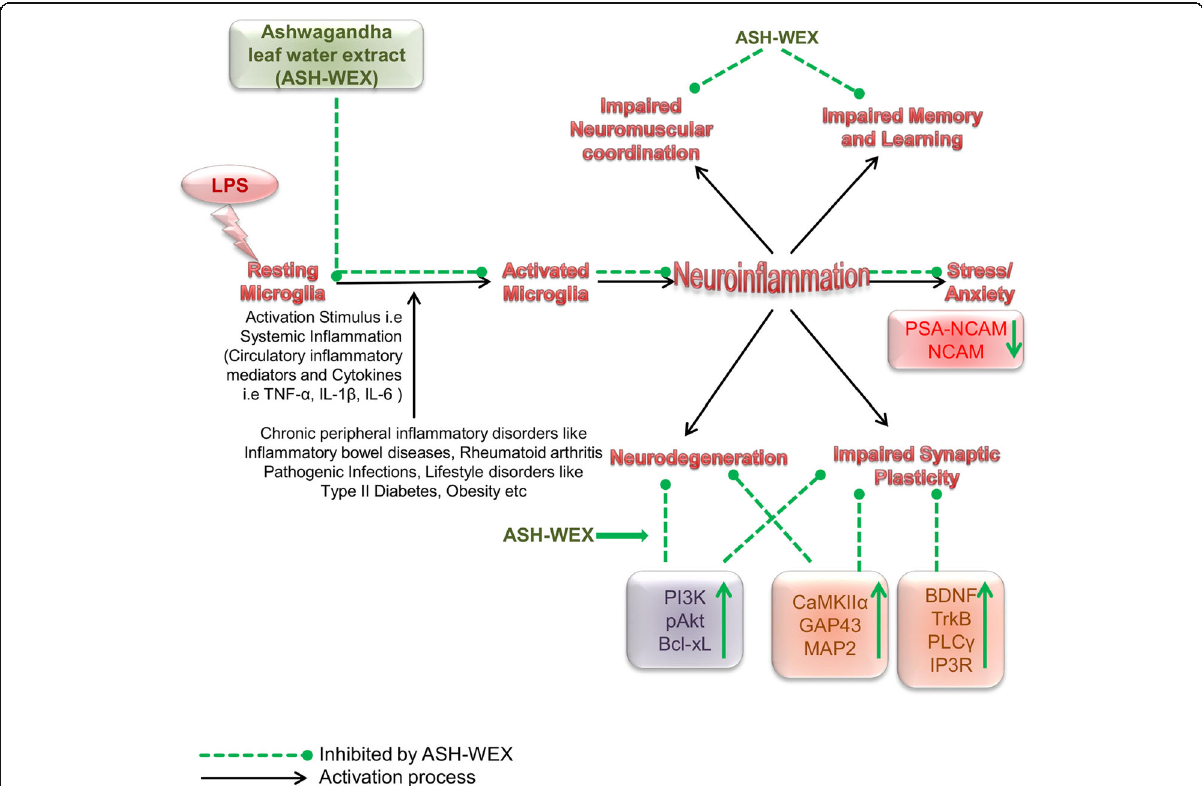
Fig. 8 Graphical representation of the study LPS (i.p.) induced sickness behavior, systemic inflammation driven neuroinflammation, and ultimately leads to neurodegeneration by adversely affecting key pathways involved in synaptic plasticity and cell survival. ASH-WEX supplementation reduced stress, sickness behavior and promoted the working memory and learning functions as well as neuro-muscular coordination impaired by LPS treatment. Ashwagandha exhibits its pleotropic neuroprotective activity by targeting various pathways and proteins involved in synaptic plasticity and cell survival such as BDNF-TrkB, PLC γ -IP3, PI3K-Akt pathways thereby promoting neuronal health and vitality. ( ↑ indicates “ upregulation ” , ↓ indicates “ downregulation ” , dotted arrows in green color indicate “ inhibitory effects mediated by ASH-WEX ” , and solid black arrows indicate “ activation ”